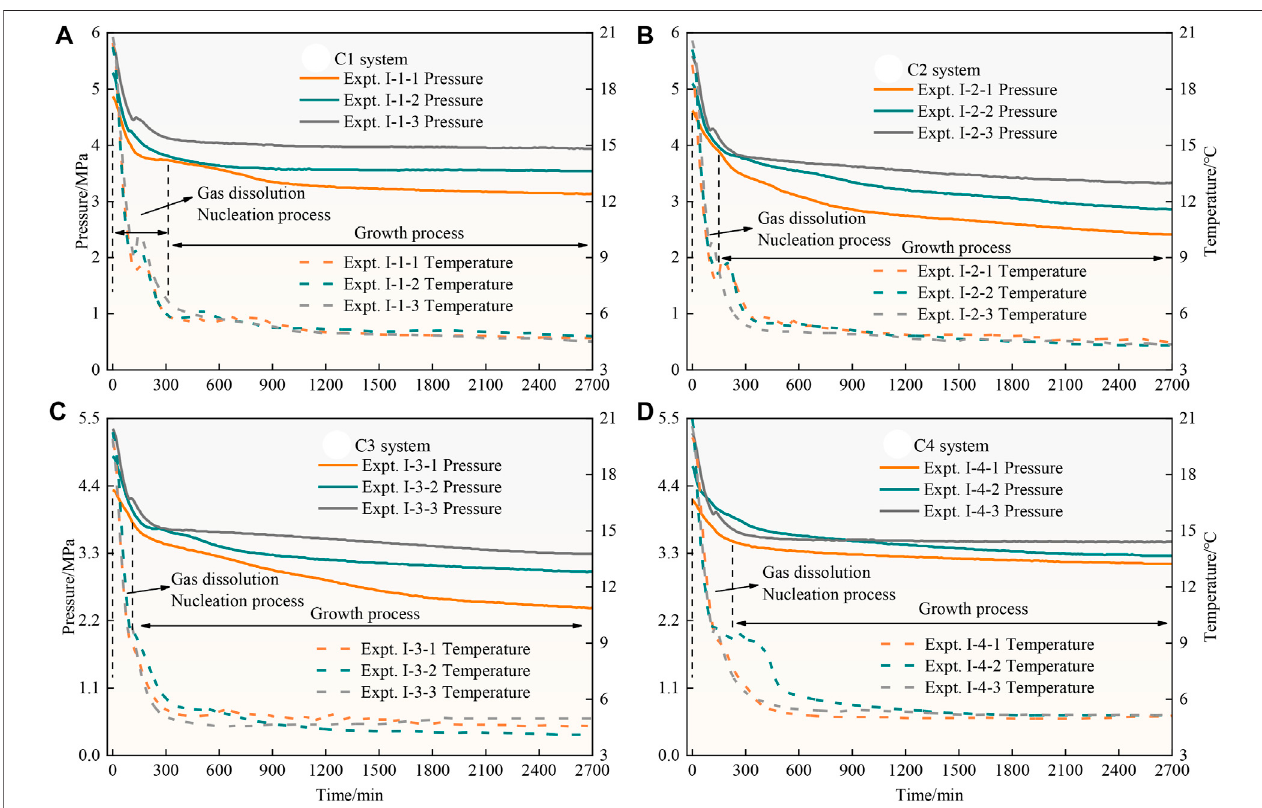
FIGURE 3 | P – T – t curves during CO 2 hydrate generation in the C1-C4